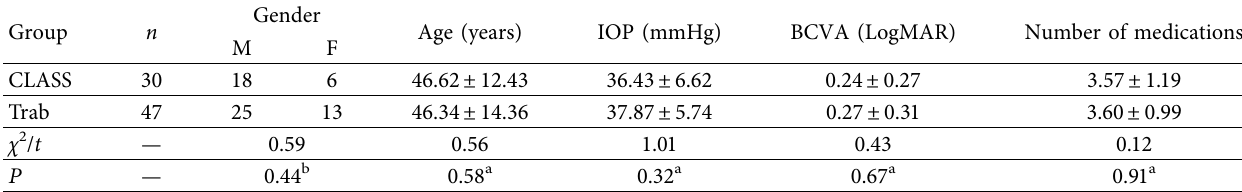
Table 1: Patients’ information of the two groups before the